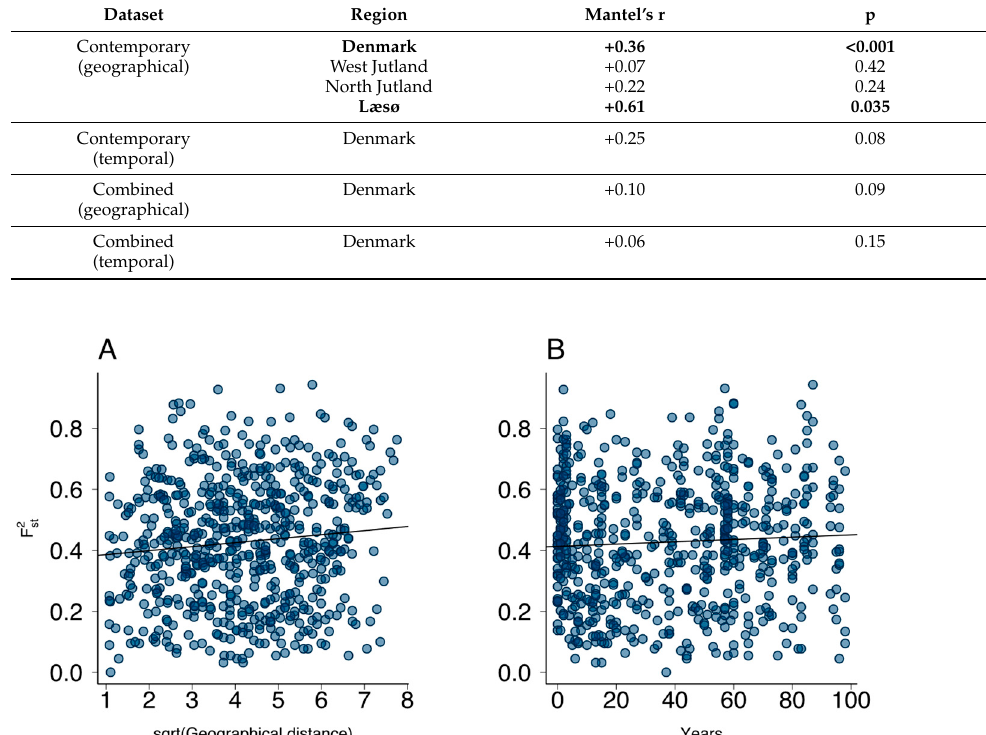
Figure 11. Plots showing isolation by distance ( A ) and year ( B ) for the combined dataset. Table 4. Summary of Mantel tests of isolation by distance and isolation by time for the different datasets. The highly significant results for isolation by distance for the contemporary dataset are also broken down by region. Statistically significant associations are shown in bold.